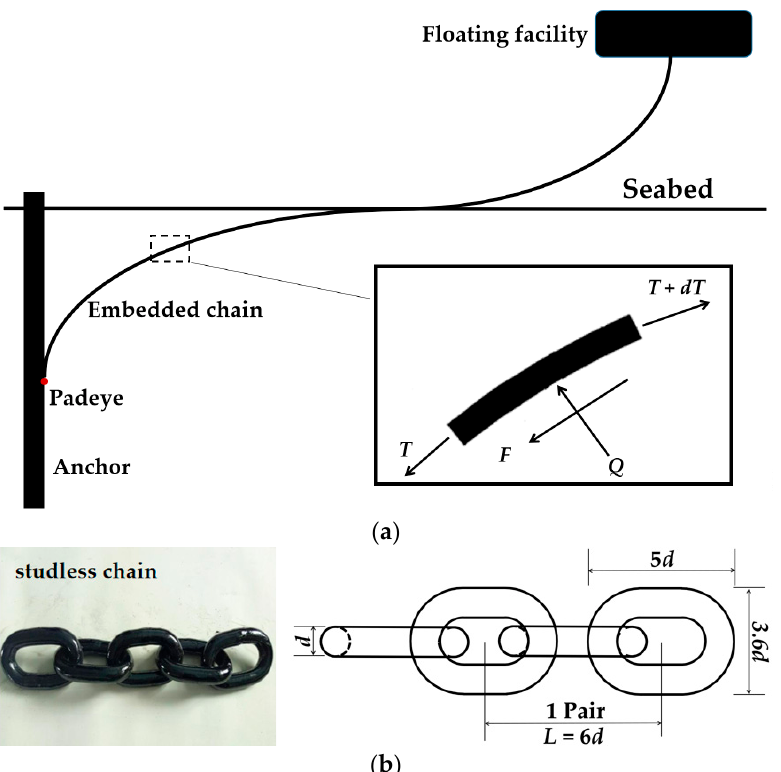
Figure 1. Mooring system and the physical geometry of the chain: ( a ) mooring system; ( b ) chain geometry.